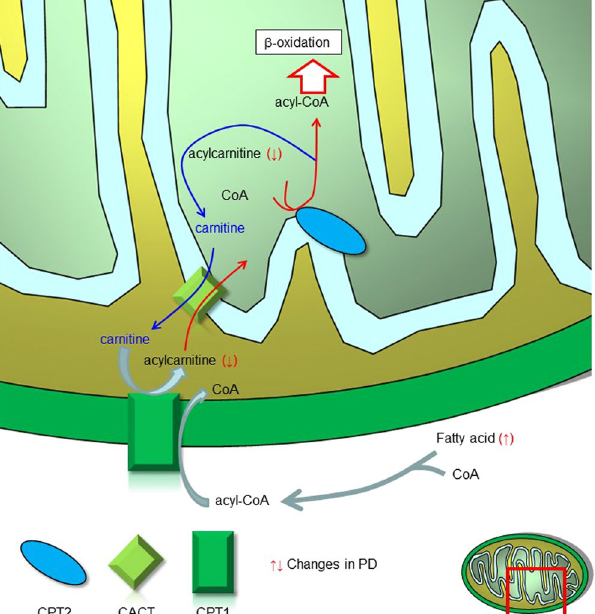
Figure 4. Schematic figure of carnitine shuttle in the mitochondria. Acyl-CoA, derived from fatty acid, is unable to penetrate the mitochondrial outer membrane. Using carnitine palmitoyltransferase activity, acyl-CoA is transformed to acylcarnitine, which is then shuttled into the mitochondrial matrix by carnitine-acylcarnitine translocase. Finally, acylcarnitine is converted to acyl-CoA by carnitine palmitoyltransferase 2 localized on the inner mitochondrial membrane. Abbreviations: CPT1 = carnitine palmitoyltransferase I; CPT2 = carnitine palmitoyltransferase II; CACT = carnitine-acylcarnitine translocase; PD = Parkinson’s